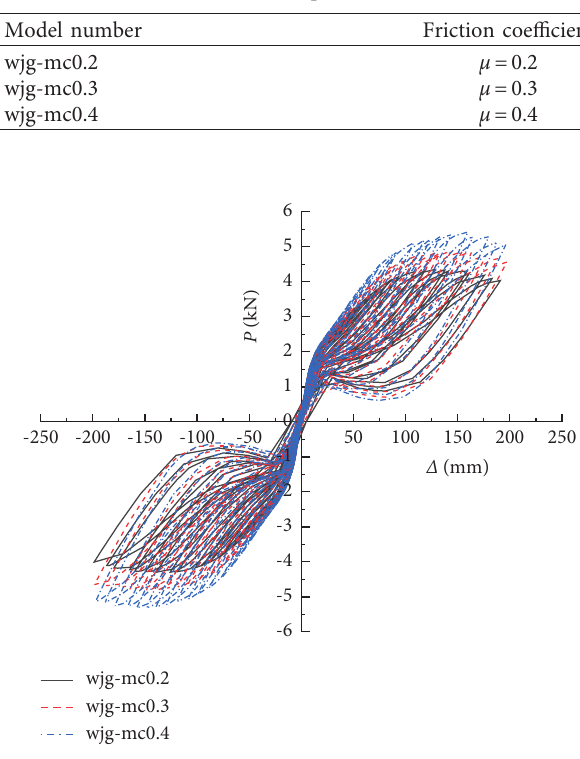
Figure 22: Hysteretic curves of group C models.